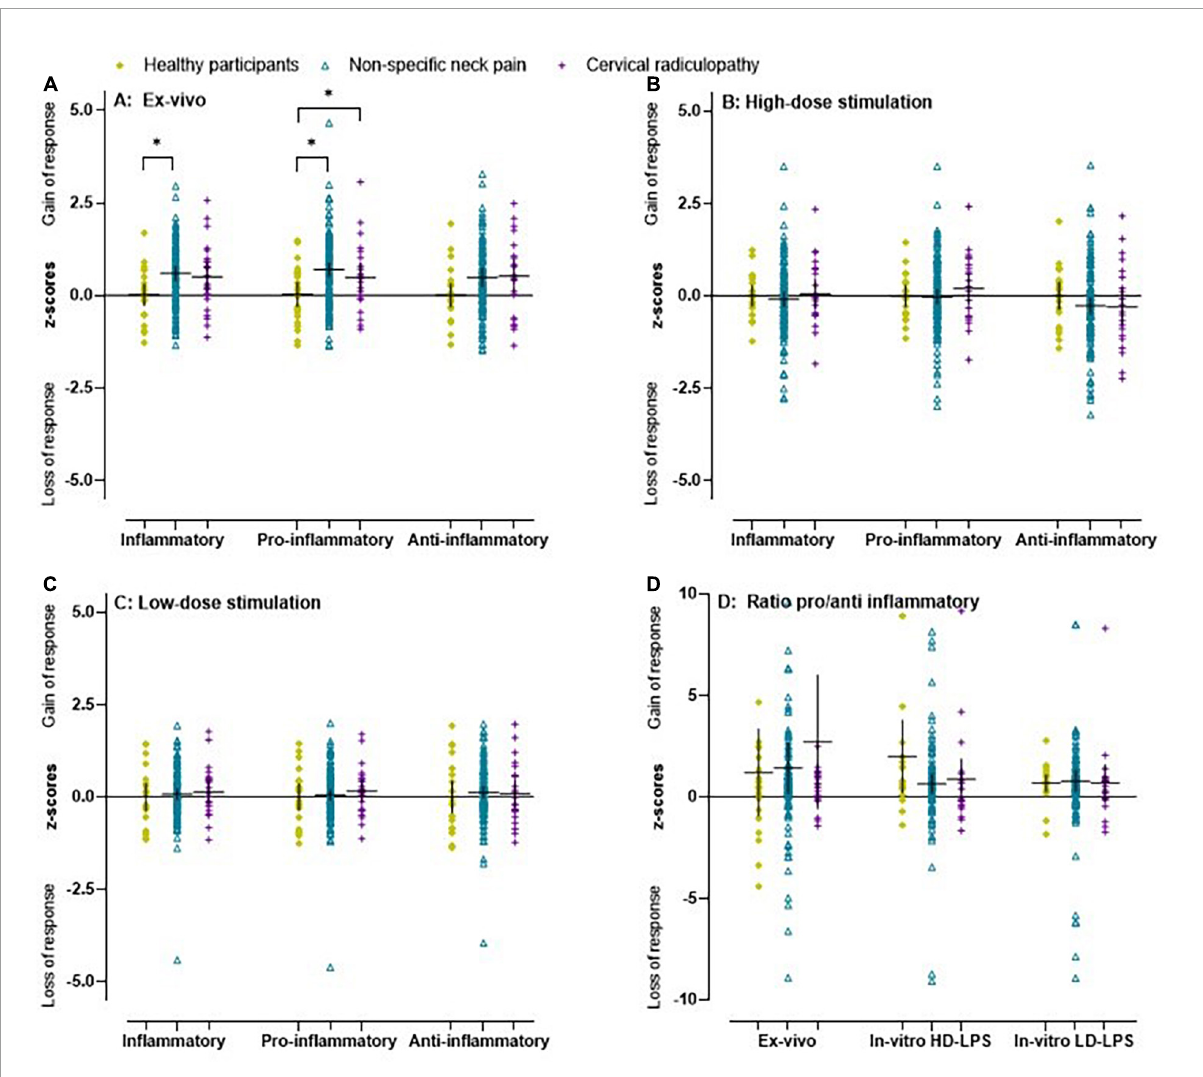
FIGURE1 Scatter plot and mean (95% CI) of z -scores for inflammatory indices in people with non-specific neck pain, cervical radiculopathy and healthy participants. (A) Ex vivo inflammatory, pro-inflammatory, and anti-inflammatory index in healthy participants, people with non-specific neck pain and cervical radiculopathy. (B) The in vitro inflammatory, pro-inflammatory, and anti-inflammatory indices after whole blood stimulation with TLR4 agonist lipopolysaccharide at a concentration of 10 µ g/ml (high dose LPS) in healthy participants, people with non-specific neck pain and cervical radiculopathy. The in vitro values were first/1,000 monocytes normalized, Ln-transformed, and finally z -score standardized. (C) Inflammatory indices at a concentration of 1 ng/ml (low dose LPS) in healthy participants, people with non-specific neck pain and cervical radiculopathy. (D) The ratio between the in vitro 10 µ g/ml, in vitro 1 ng/ml, and ex vivo pro-inflammatory and anti-inflammatory index in healthy participants, people with non-specific neck pain and cervical radiculopathy. Lines represent mean ( horizontal line ), and 95% CI. The scatter plot was based on the individual points of 112 people with non-specific neck pain, 25 with cervical radiculopathy and 23 healthy participants. *Represents a significant difference between groups ( p < 0.05).